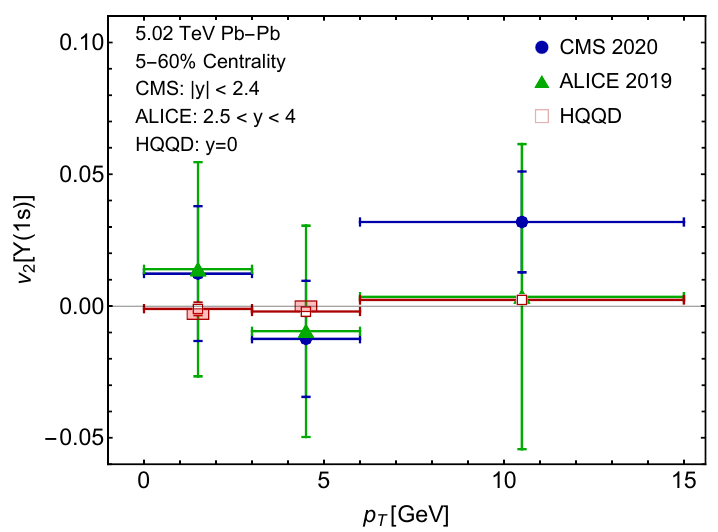
Figure 6 . The elliptic flow v 2 [Υ(1 s )] as a function of p T in three p T -bins. Open red squares are HQQD predictions and the data are from the ALICE [82] and CMS [83] collaborations. The shaded red boxes associated with each HQQD prediction indicate the systematic variation observed when changing the model parameters in the range specified in eq. (6.1). Note that, for the highest p the systematic error estimate is so small that it is indistinguishable from the horizontal error bar.